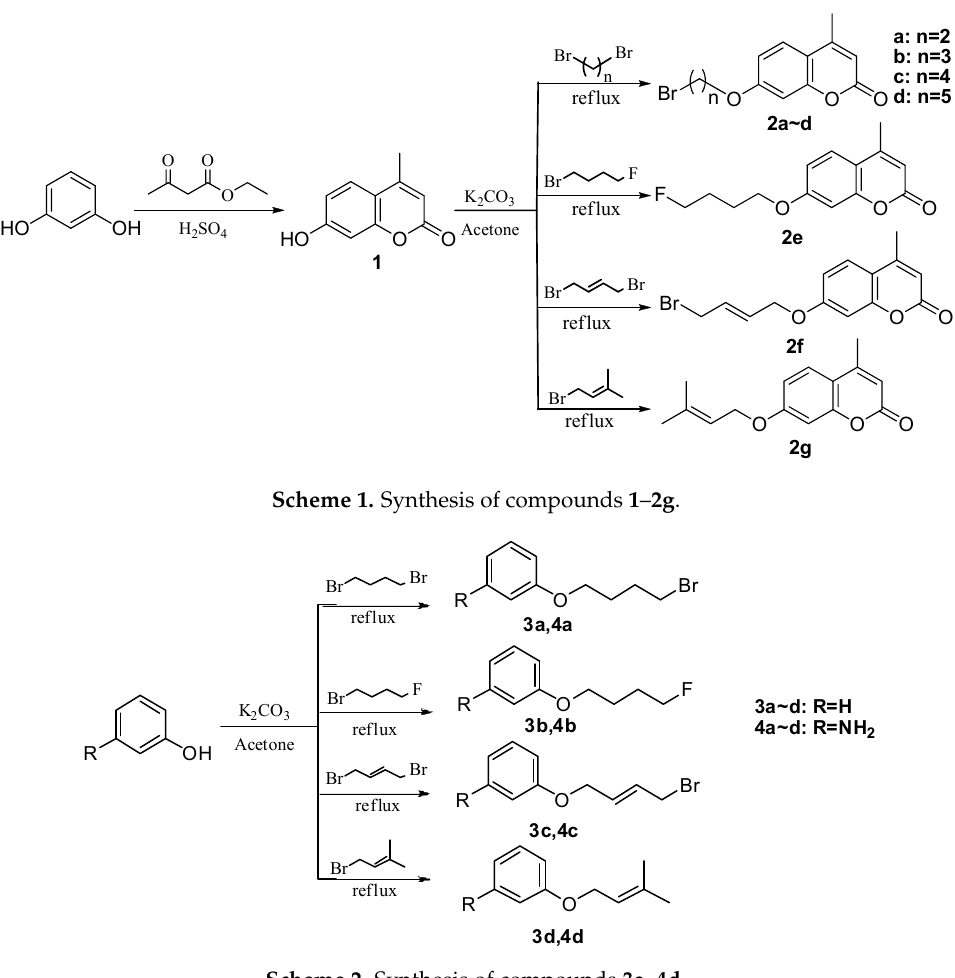
Scheme 2. Synthesis of compounds 3a – 4d